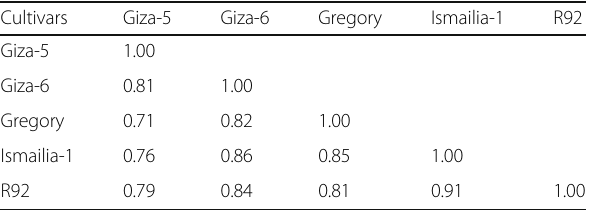
Table 6 The genetic similarity matrix of five peanut cultivars based on RAPD markers